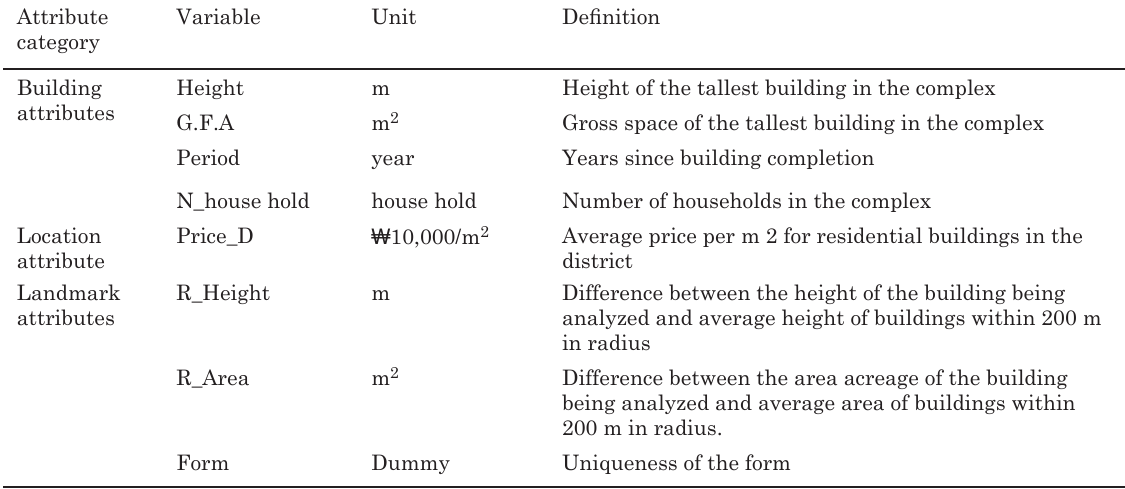
table 4. price explanatory variables for super high rise residential